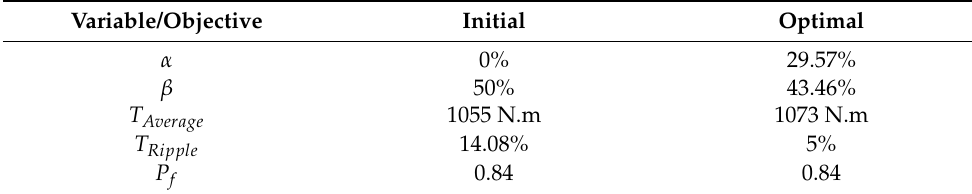
Table 6. The comparison of the quantity values of the optimized and initial prototypes.